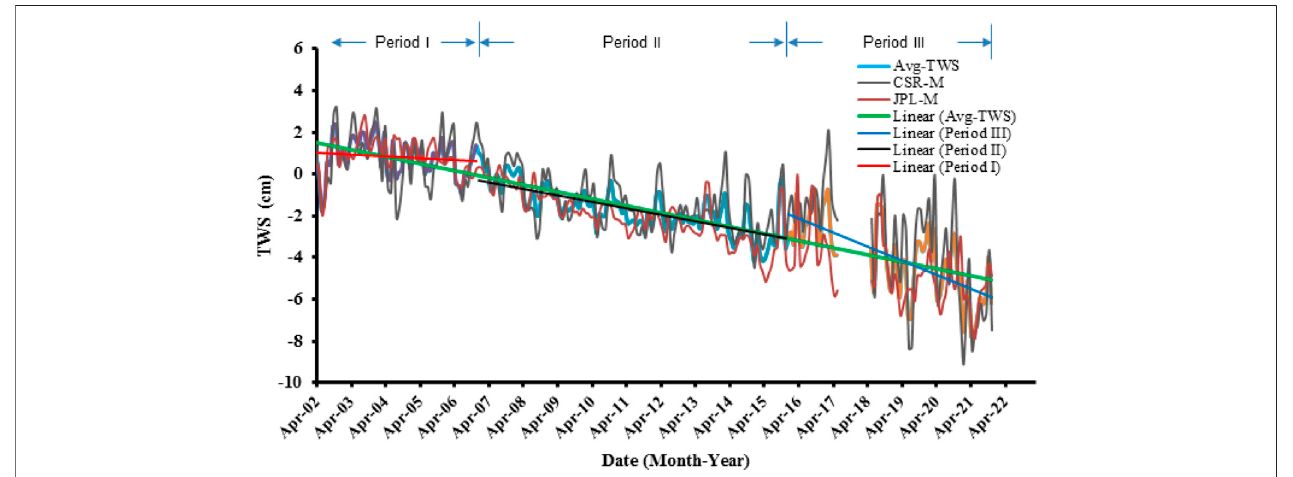
FIGURE 6 | Δ TWS from JPL-M and CSR-M mascon products across the study area, as well as their averaging (Avg-TWS) during the investigated time.